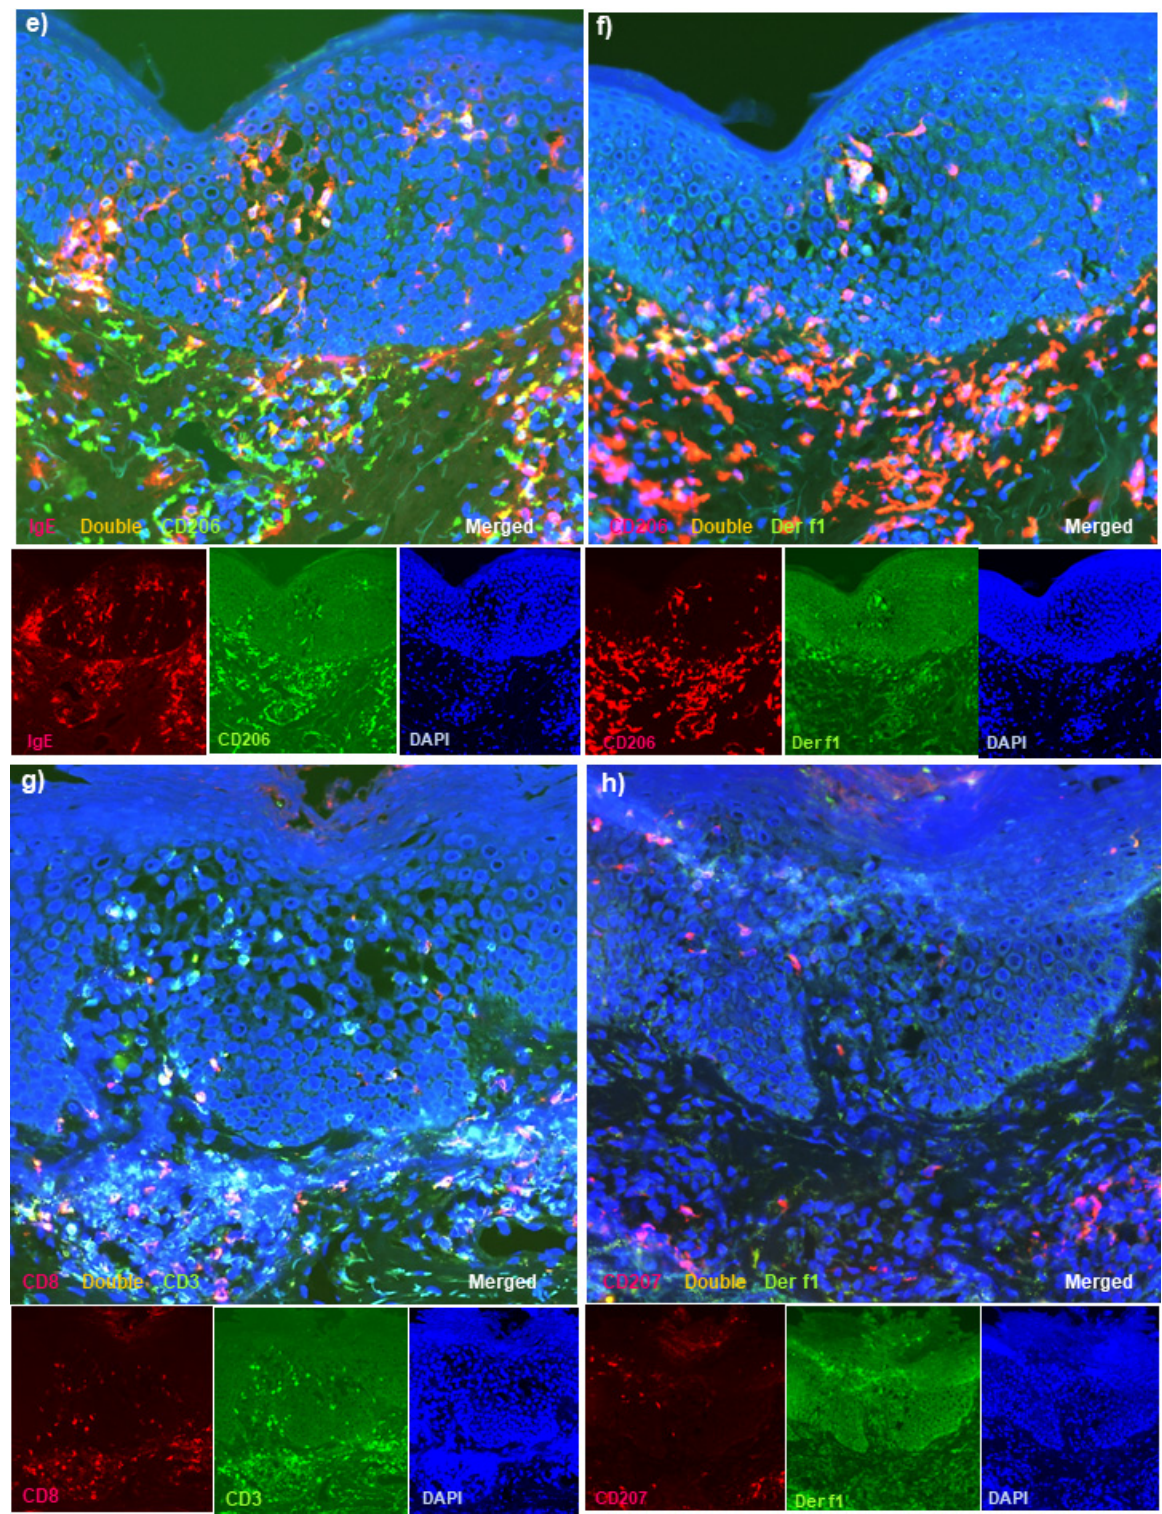
Figure 1. Routine and double-immunofluorescence staining for active lesions of chronic AD in patients with IgE-allergic AD and HDM allergy. ( a ) Chronic eczematous reactions with a scaly crust, epidermal hyperplasia, and obvious spongiosis with mononuclear cell infiltration were observed in the epidermis. ( b ) Double-positive IgE+ CD206+ cells (yellow) markedly infiltrated into the spongiotic epidermis of the active lesions of chronic AD. ( c ) Double-positive IgE+ Der f1+ cells (yellow) were observed among the infiltrating cells in the same spongiotic epidermis. ( d ) Double-positive CD206+ Der f1+ cells (yellow) were also found among the infiltrating cells in the same spongiotic epidermis. ( e ) Double-positive IgE+ CD206+ cells (yellow) were observed in the spongiotic epidermis of active lesions of chronic AD. ( f ) Double-positive CD206+ Der f1+ cells (yellow) were found among the infiltrating cells in the same spongiotic epidermis. ( g ) Both double- positive CD3+ CD8+ cells (yellow) and single-positive CD3+ CD8 − cells (green) were also observed in the spongiotic epi- dermis. ( h ) CD207+ cells (red) were less localized to the central area, and some double-positive CD207+ Der f1+ cells (yel- low) were present in the peripheral area of the spongiotic epidermis. ( a ): Case 1; hematoxylin-eosin staining. ( b – d , g , h ): Case 1; double-immunofluorescence staining. ( e , f ): Case 6; double-immunofluorescence staining. In the double-immuno- fluorescence staining, nuclei were labeled with 4 ′ ,6-diamidino-2-phenylindole (DAPI; blue). Sets of figures, i.e., ( b – h ), represent serial sections. Original magnifications: 100×, ( a ); 200×, ( b – h ).